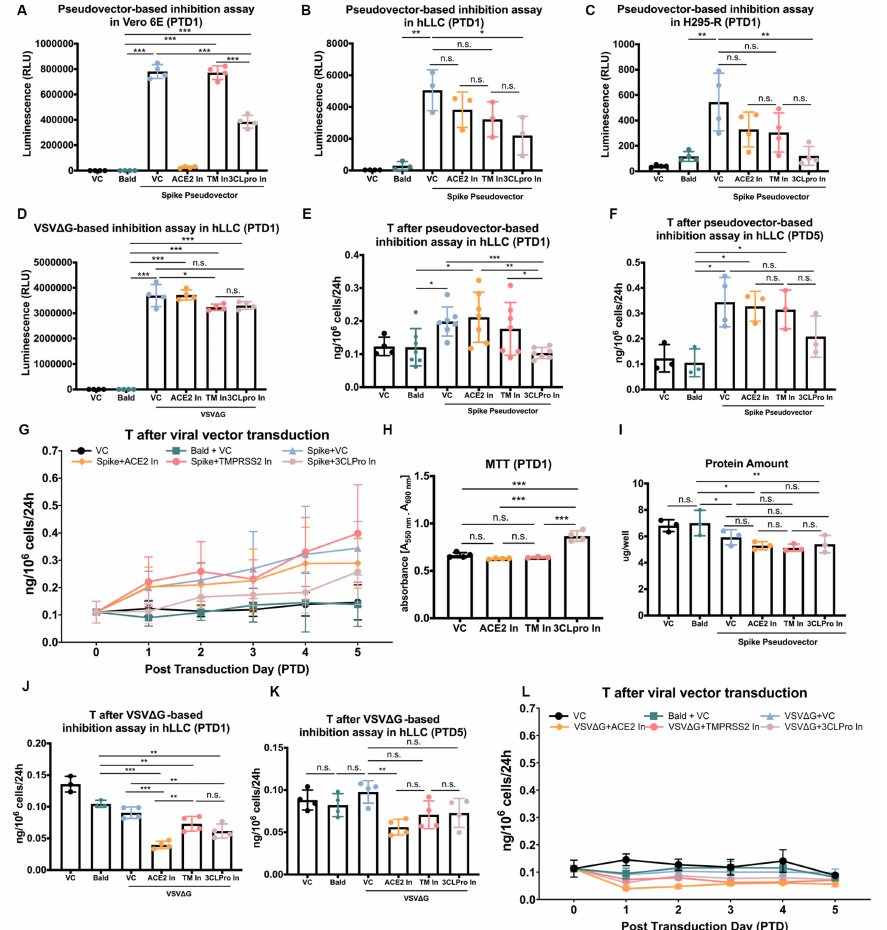
Figure 6. SARS-CoV-2 spike pseudovectors enter hLLCs through pathways different from those in Vero E6 cells. ( A – C ) Inhibitors preventing entry of SARS-CoV-2 spike pseudovectors were tested on Vero E6, hLLCs, and H295-R cells. ACE2 inhibitor represses entry drastically in Vero E6 cells, whereas it has only minor effects in hLLCs and H295-R cells. TMPRSS2 inhibitor only slightly affects steroidogenic cells (hLLCs and H295-R) and not Vero E6 cells. The 3CL protease inhibitor (3CLpro In) cinanserin inhibits entry of pseudovector in all cell types. ( D ) Inhibitors were tested against entry of VSV ∆ G vector in hLLCs. ACE2 inhibitor (ACE2 In) shows no inhibitory effect. TMPRSS2 inhibitor (TMPRSS2 In) significantly inhibits VSV ∆ G entry, while 3Clpro In slightly inhibits VSV ∆ G entry with no significance. ( E – G ) From PTD 1 to 5, spike pseudovector entry into hLLCs significantly promoted T production. In the presence of the three inhibitors with spike pseudovector transduction, only 3Clpro In could repress the stimulatory effects of SARS-CoV-2 spike pseudovector entry on T production. ( H ) The MTT assay results show no statistically significant differences between VC and ACE2 In or TMPRSS2 In, suggesting these inhibitors had no effect on hLLC growth or viability. However, the hLLC viability is significantly higher under 3CLpro In treatment compared to VC, ACE2 In, or TMPRSS2 In. The lack of 3CL protease expression in hLLCs implies that 3CLpro In (cinanserin) may play a role in promoting hLLC viability or stimulating hLLC growth, even though the contribution of 3CL protease to these processes may be negligible. ( I ) At PTD 5, SARS-CoV-2 spike pseudovector entry represses cell growth with or without inhibitors. ( J – L ) Comparing PTD 1 to 5, VSV ∆ G entry of hLLCs show no significant effect on T production by hLLCs. In the presence of the three inhibitors with VSV ∆ G transduction, T production by hLLCs is significantly inhibited at PTD 1 in comparison to the bald group. Data are presented as means ± SDs, n ≥ 3. Not significant = n.s.; p > 0.05; * p < 0.05; ** p < 0.01; *** p <